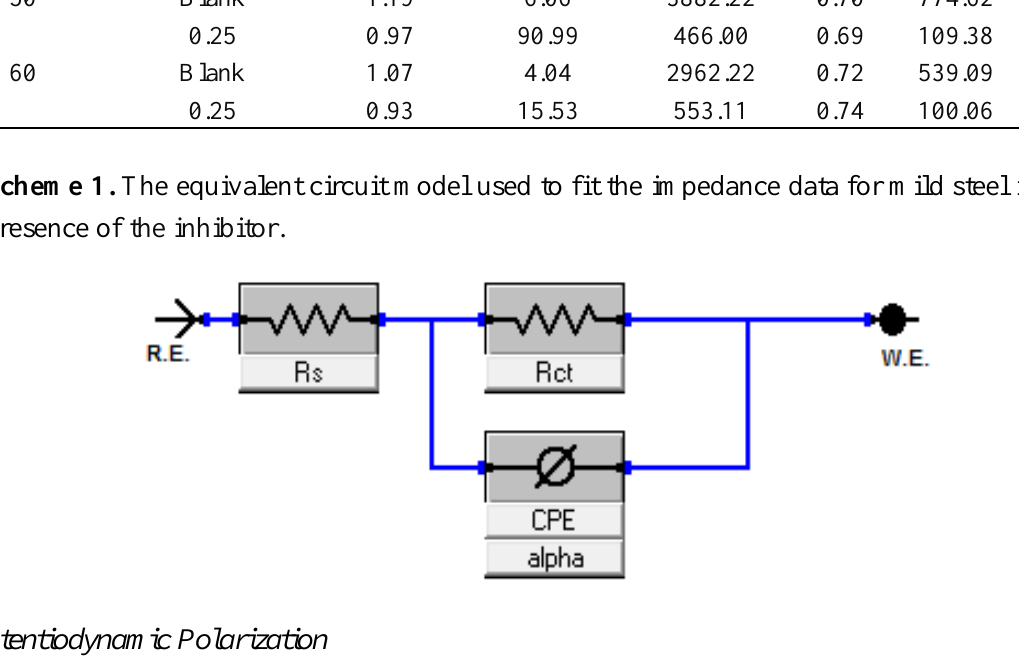
SO with 0.25 mM of the 2 4